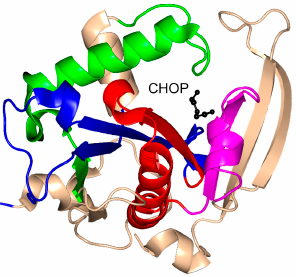
Figure 12. Cartoon representation of the structure of yeast Mpr1 in complex with cis -4-hydroxy- L - proline (CHOP) (PDB ID: 3W6X [119]). The conserved and non-conserved motifs of the